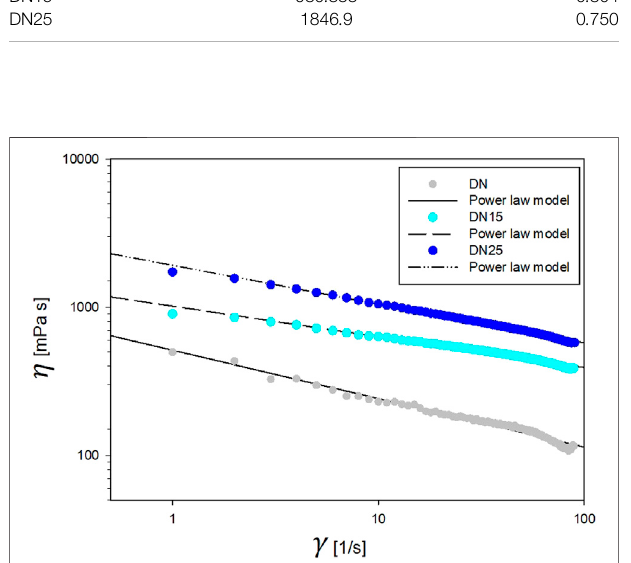
FIGURE 2 | Rheological properties of DN solutions.